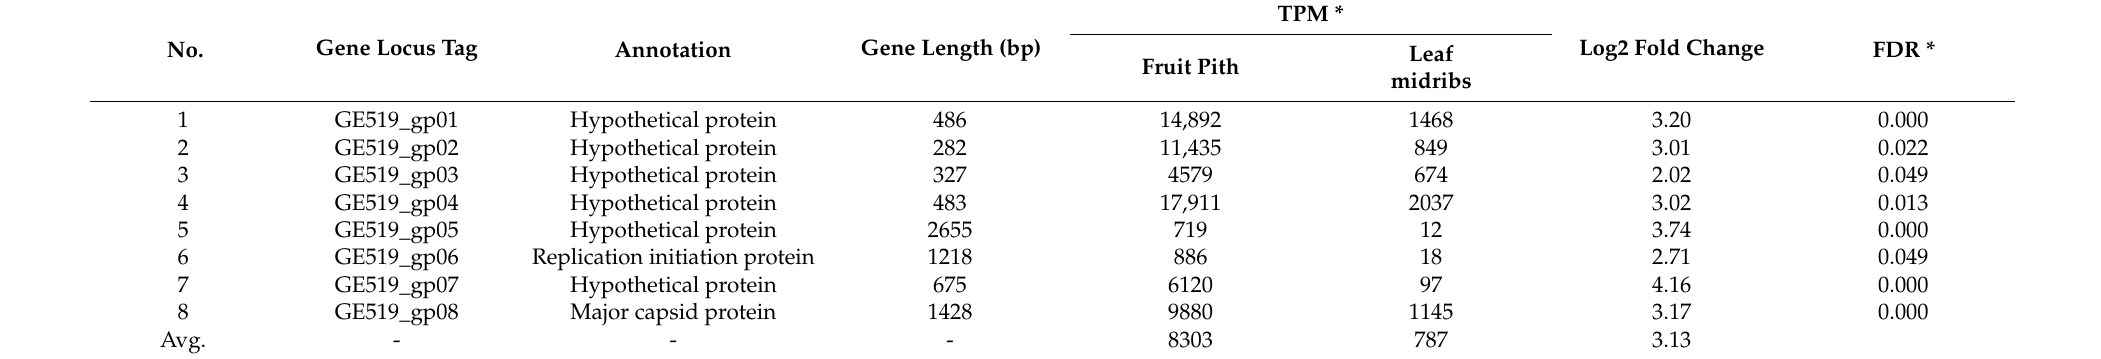
Table 4. Transcriptional level of ClasMV1 phage genes in leaf midribs and fruit